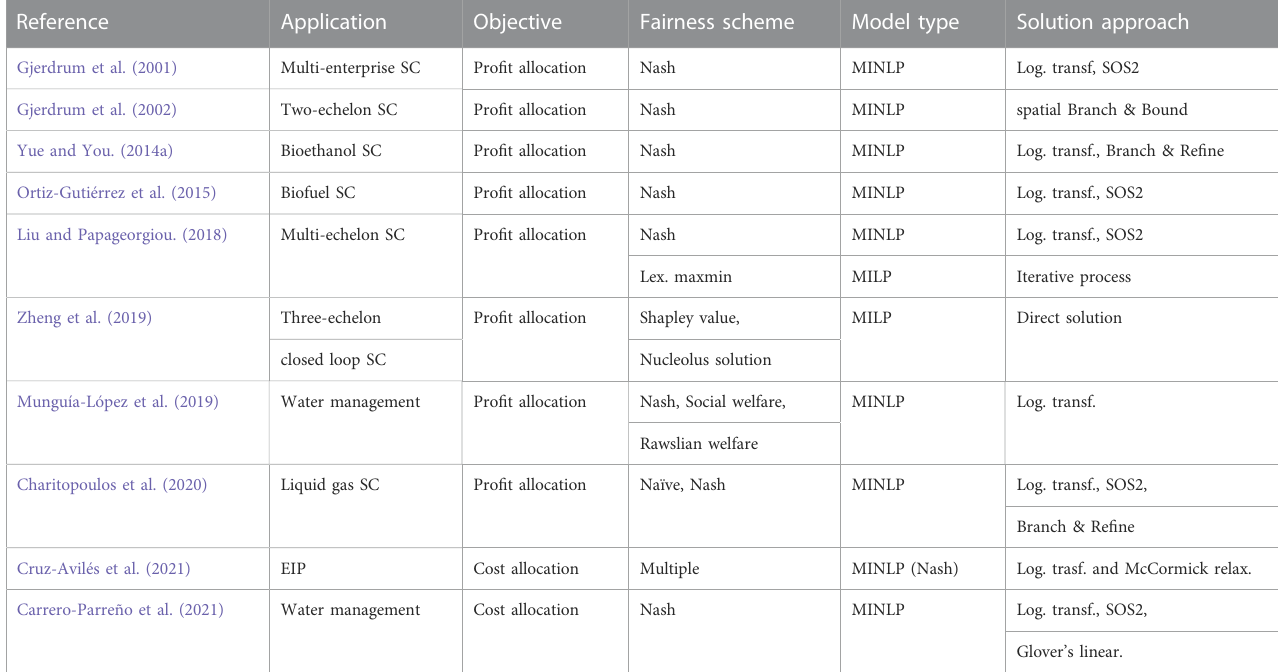
TABLE 2 Representative contributions of fairness schemes in cooperative games.